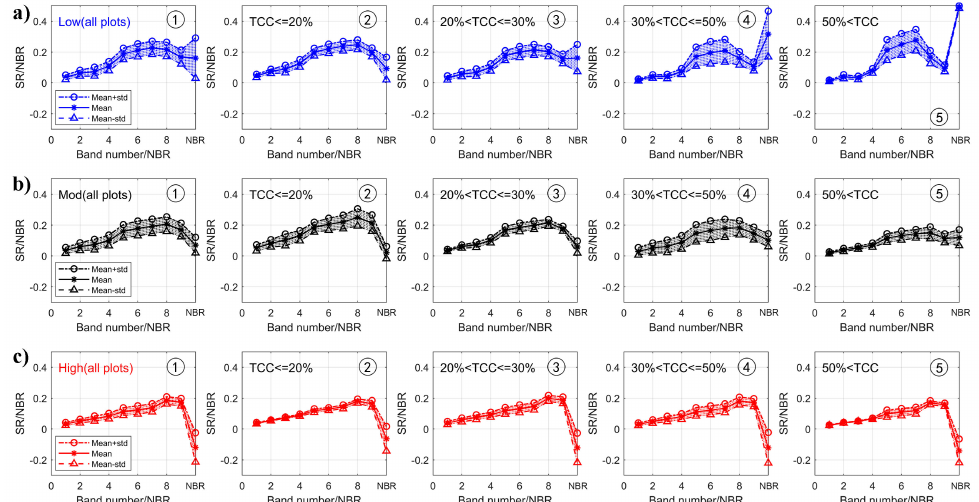
Figure 5. Mean and standard deviations (std) of the Sentinel-2A MSI spectral signatures of plots with ( a ) low, ( b ) moderate, and ( c ) high burn severities and TCC ranges. The x -axis represents the nine spectral bands and post-fire NBR, and the y -axis represents the value of the reflectance (SR) and post-fire NBR. The first column represents the reflectance from all field plots without constraining TCC; other columns represent the reflectance statistics in di ff erent TCC levels.